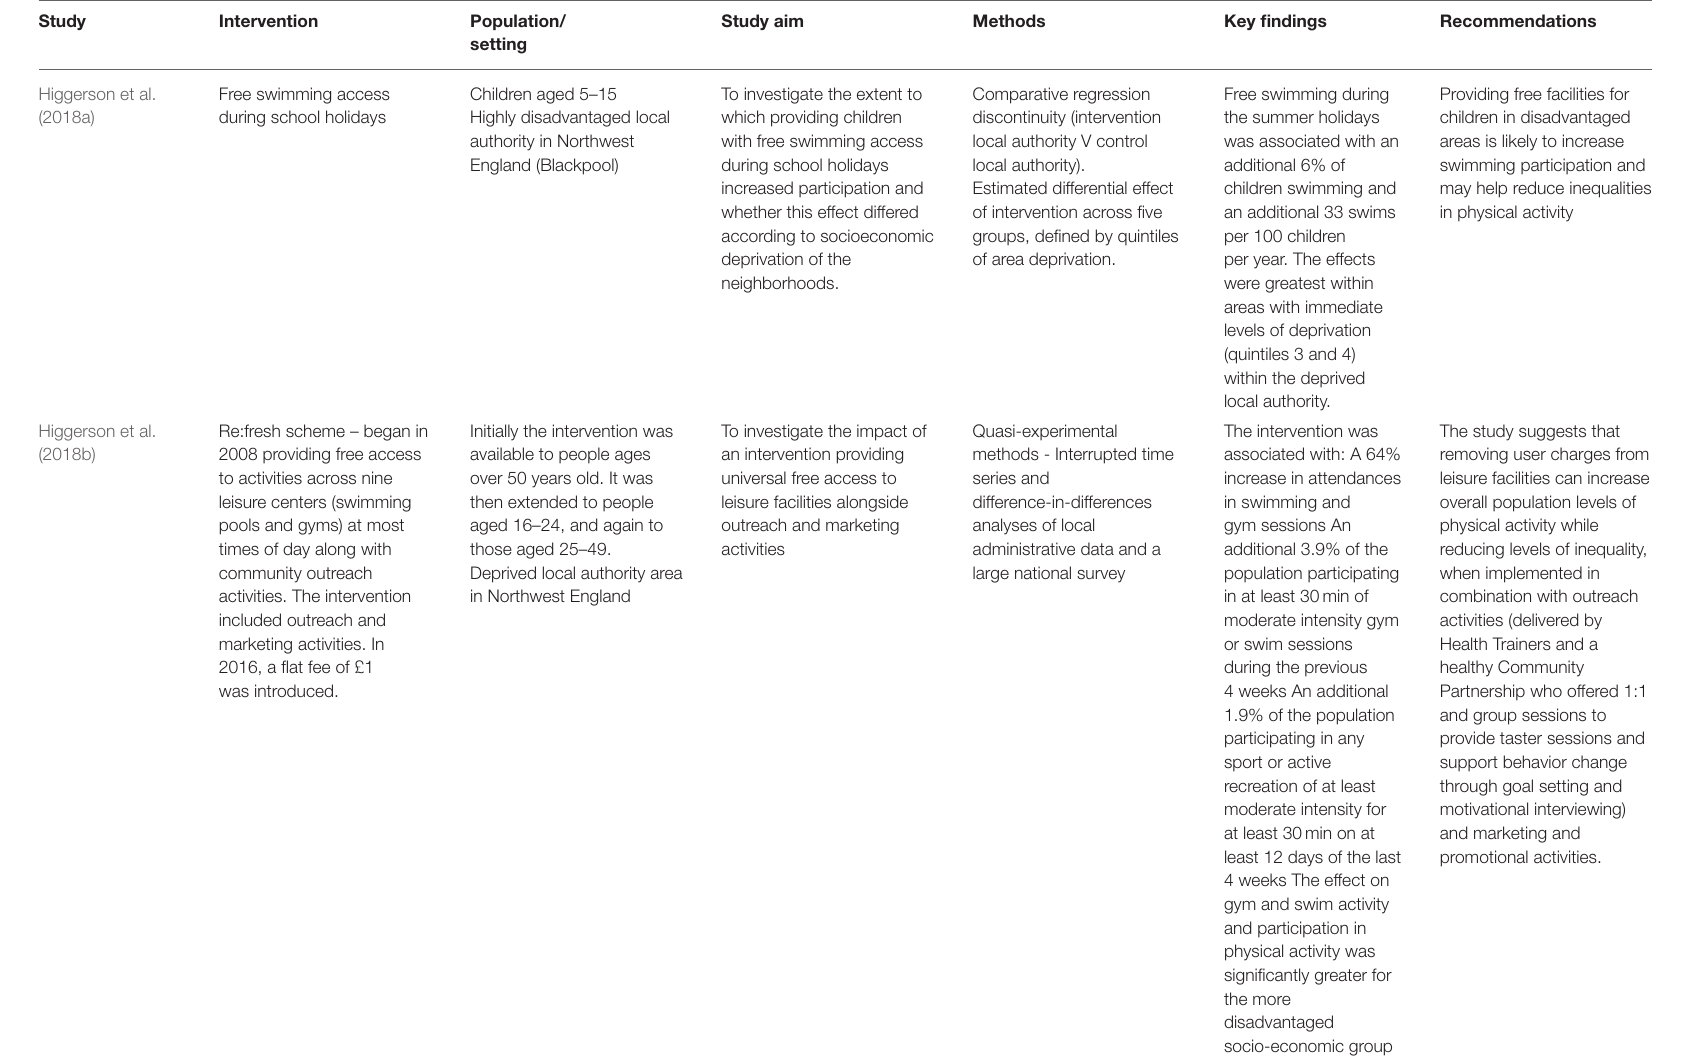
TABLE 2 | Study characteristics and data